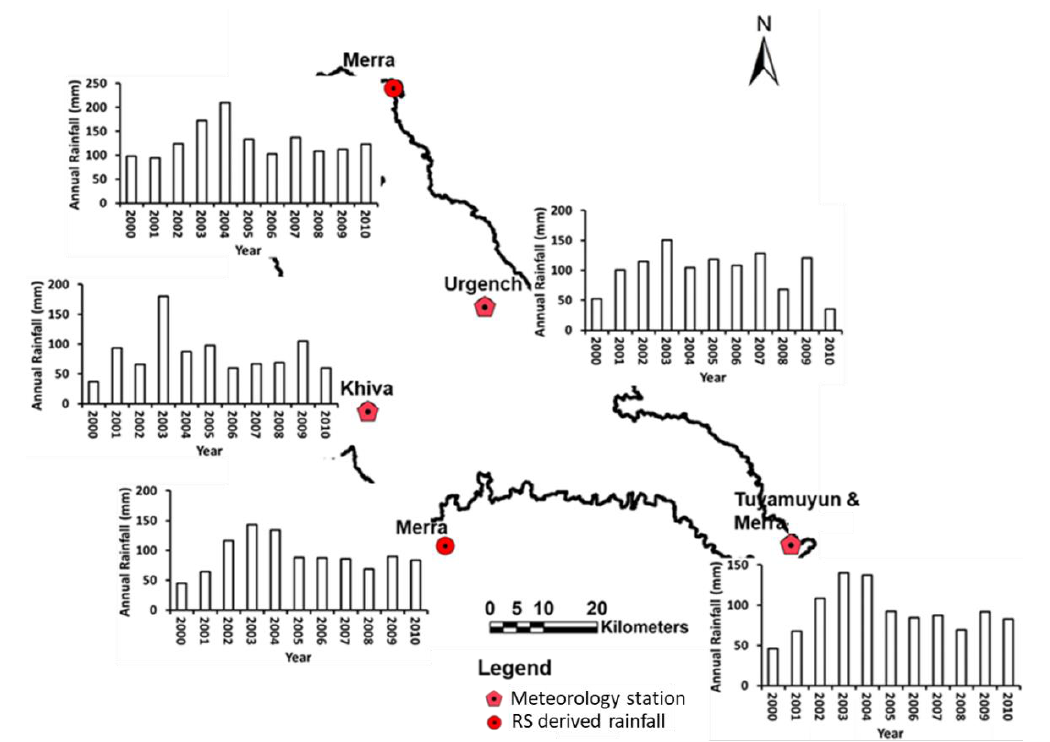
Figure 4. Locations of meteorological stations and the spatial distribution of annual precipitation during 2000–2010 as recorded by three stations and as estimated through remote sensing (RS) in the Khorezm region, Uzbekistan. Source: Reference [15] .